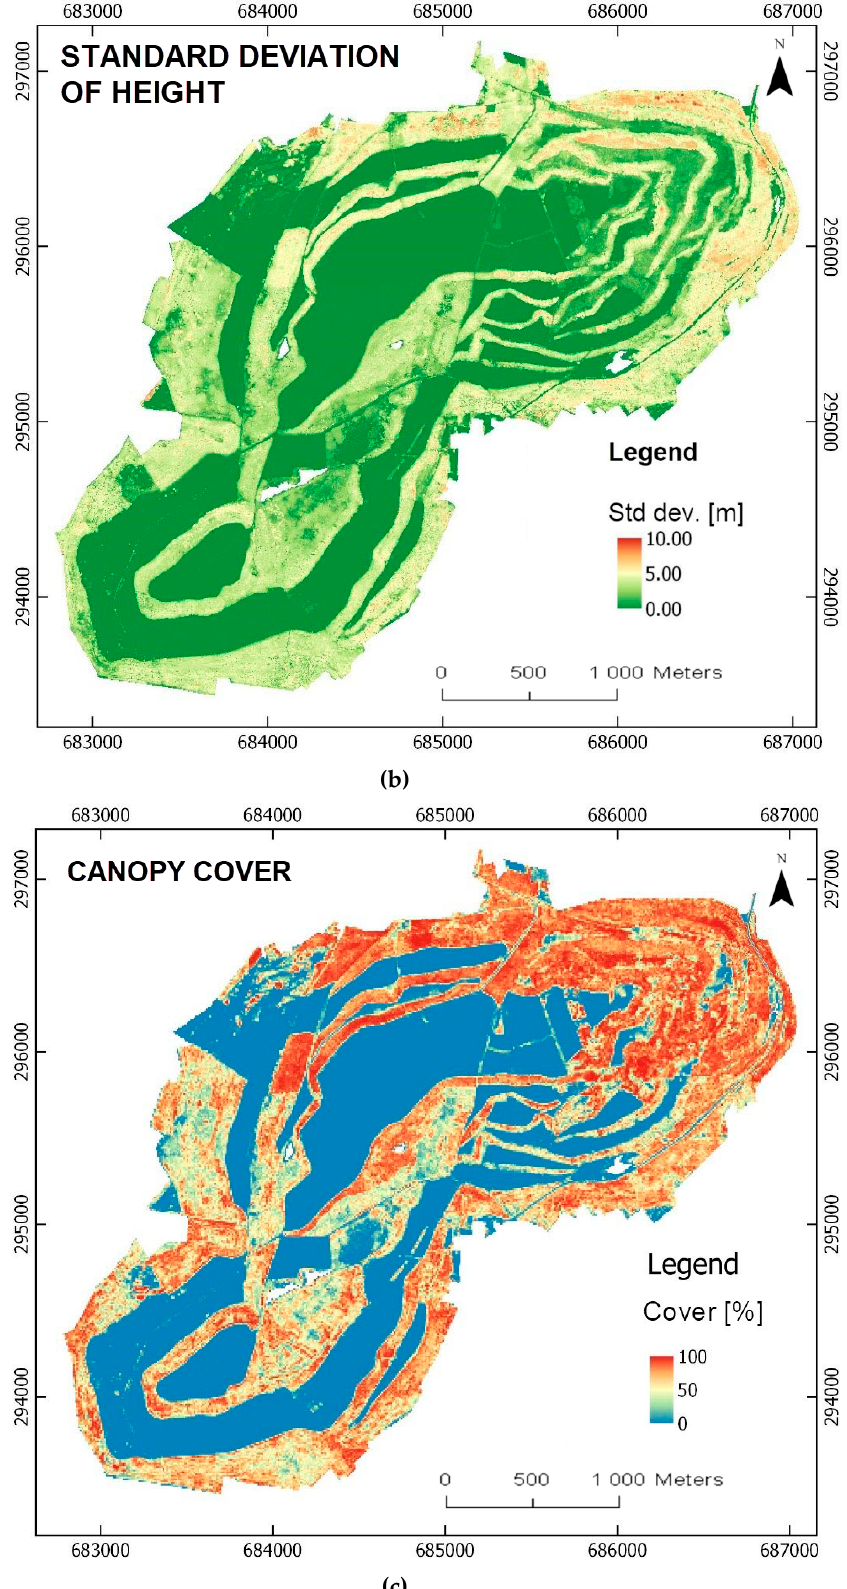
Figure 5. Vegetation parameters for the Machów analysed area (ALS, 2012): ( a ) height of vegetation (95th percentile), ( b ) standard deviation of height, and ( c ) canopy cover (value of 0%–100%).